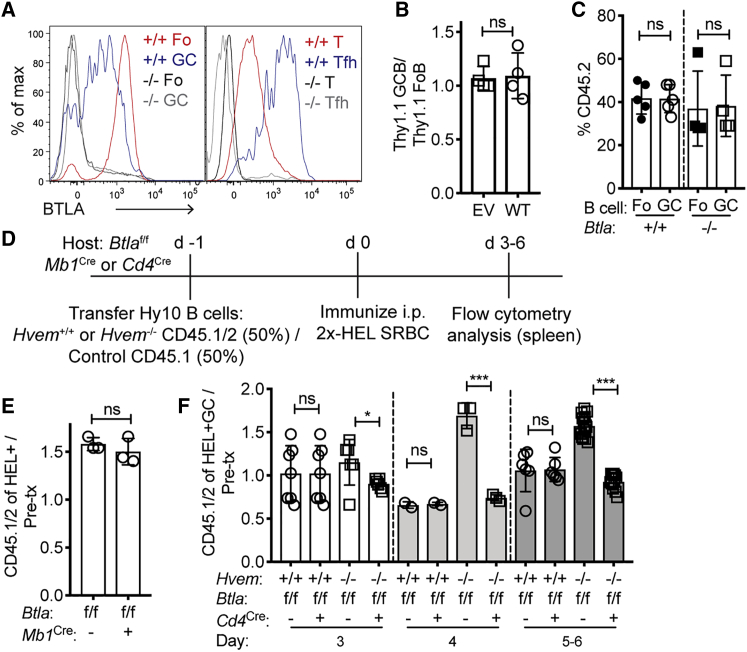
BTLA on T Cells Restrains GC B Cell Competitiveness(A) Flow-cytometric analysis of BTLA expression on B cells (left) and CD4+ T cells (right) compared with Btla−/− cells.(B) HVEM-overexpressing Btla−/− BM chimeras were made by transduction of empty vector (EV) or HVEM (WT) MSCV-Thy1.1 constructs into Btla−/− BM and reconstitution of CD4-depleted hosts. Chimeras were then immunized with SRBCs, and the participation of Thy1.1+ cells in GC versus Fo B cells was determined.(C) Contribution of Btla+/+ or Btla−/− CD45.2 cells to Fo and GC populations in the spleen of mixed BM chimeras made with ∼40% CD45.2 and ∼60% WT CD45.1 at day 7 after SRBC immunization.(D) Experimental scheme and timeline for experiments in (E) and (F).(E) Ratio of the frequency of CD45.1/2 Hvem−/− HEL+ B cells in BTLA-B-cell-deficient (Btlaf/fMb1Cre) hosts at day 5 to the pre-transfer frequency.(F) Ratio of CD45.1/2 Hvem+/+ or Hvem−/− HEL+ GC B cells to the pre-transfer mix in BTLA-T-cell-deficient (Btlaf/fCd4Cre) hosts at days 3–6. Data are pooled from four experiments.Unpaired two-tailed Student’s t test (B, C, E, and F): ∗p < 0.05, ∗∗p < 0.01, ∗∗∗<P0.001, ∗∗∗∗p < 0.0001. See also Figure S3.